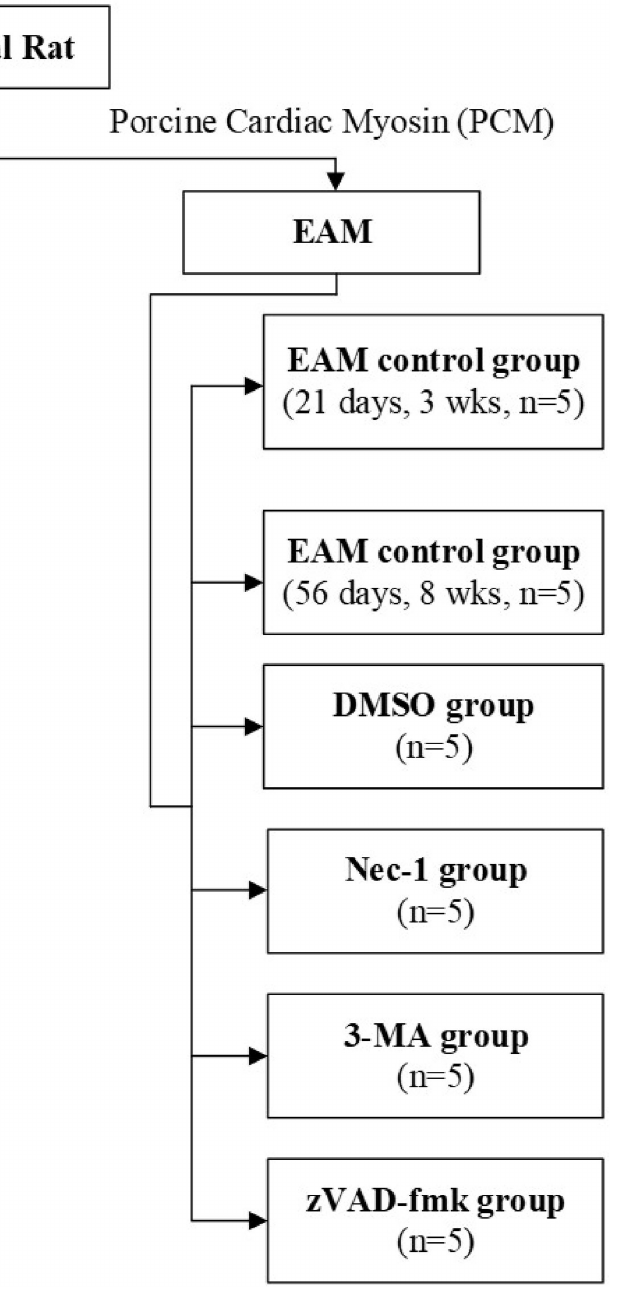
FIGURE 1 | Flowchart of rats used in